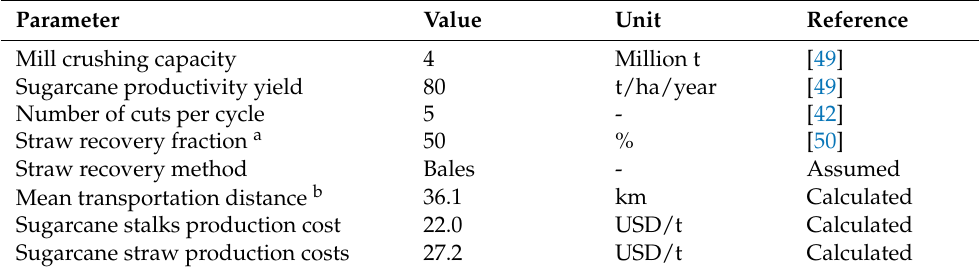
Table 1. Main parameters adopted for the biomass production system.